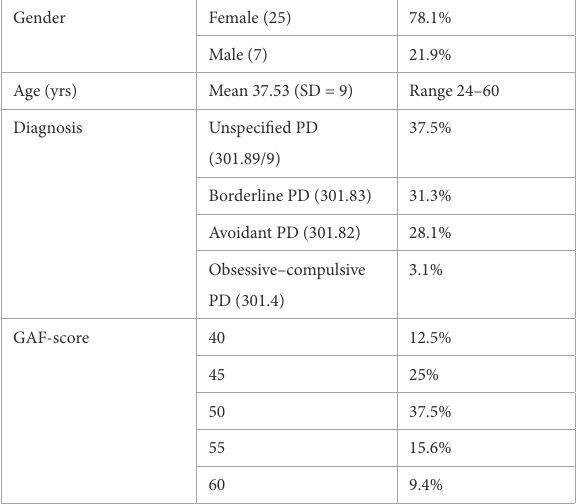
TABLE 1 Demographics of the participants ( N = 32).